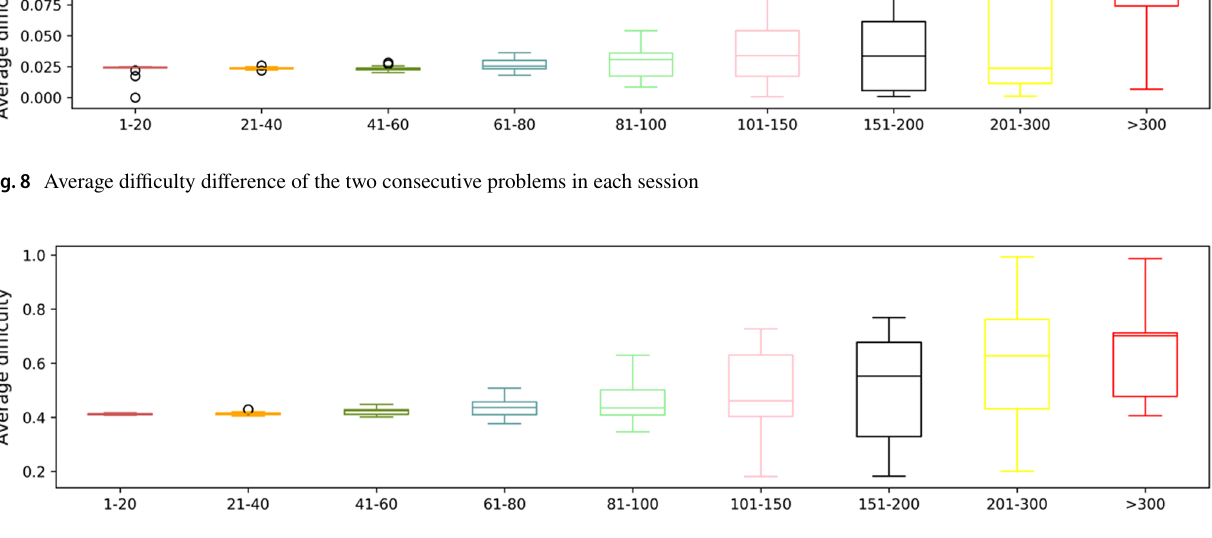
Fig. 9 Average difficulty of problems in each